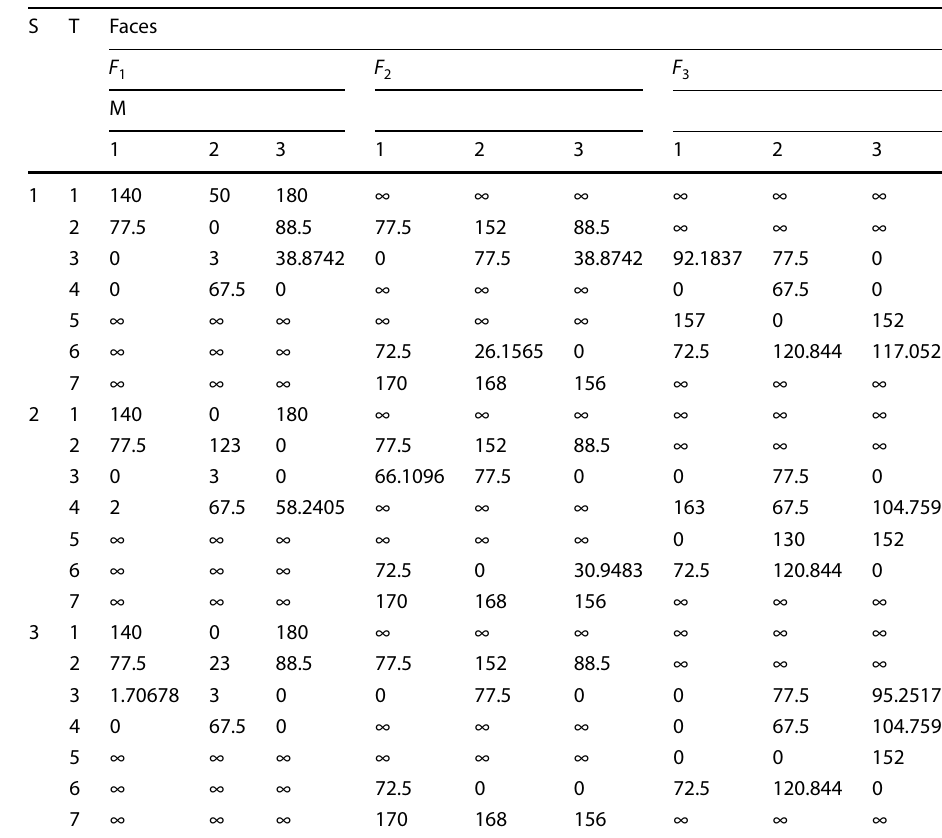
Table 5 Scheduling the activation of a sensor i for each face f of a mission m